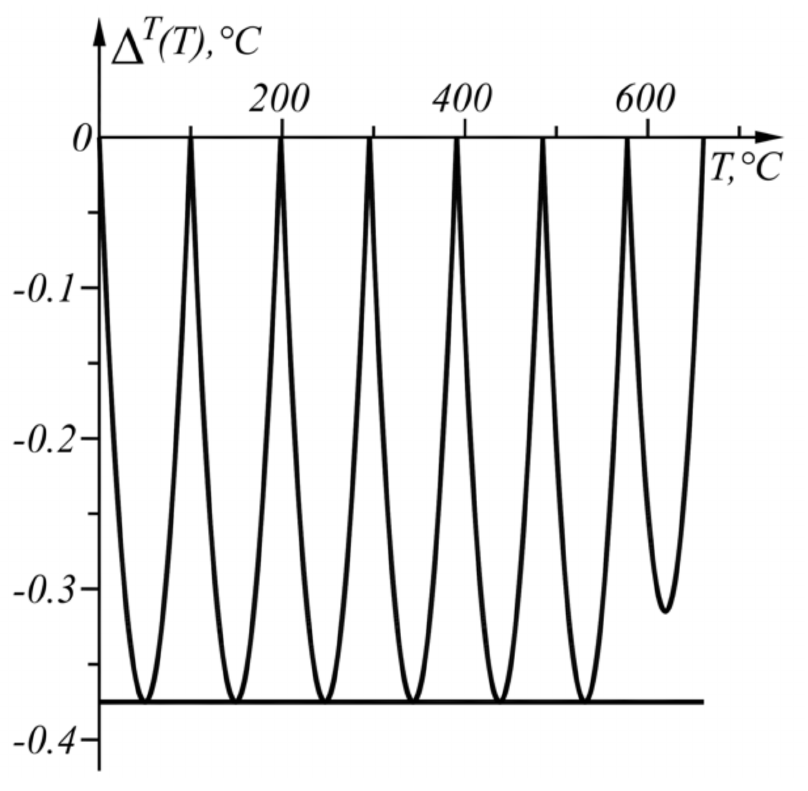
Figure 8. Graph of the function ∆ T ( T ) in the range T ∈ [ 0, 661 ] ◦